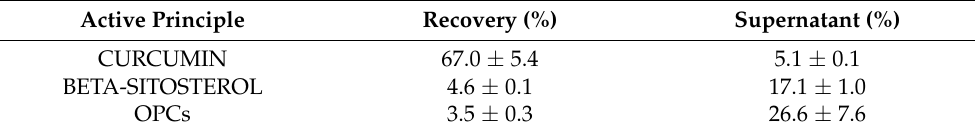
Table 2. Bioaccessibility of the active principles contained in the LENILUTS ® formulation following in vitro digestion. Data are expressed as mean ± standard deviation.